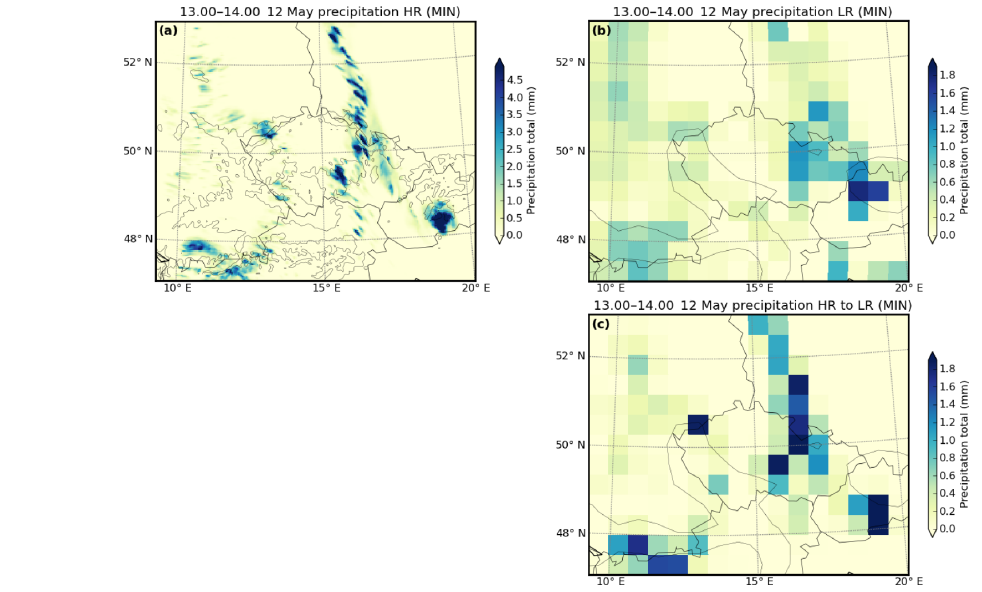
Figure 7. Precipitation amount (in mm) between 13:00 and 14:00UTC on 12 May 2013 for the MIN HR simulation (a) , MIN LR simula- tion (b) and the HR simulation aggregated on the LR grid by averaging on each LR grid cell the 15 × 15 matching HR grid cells (c)